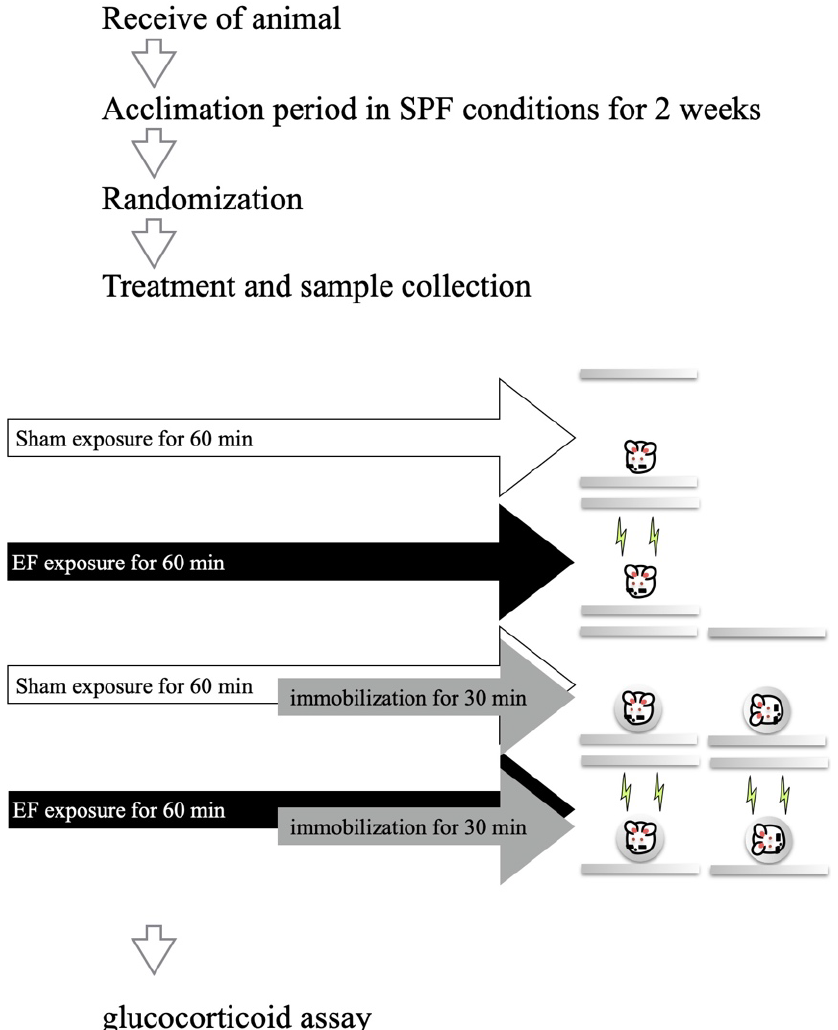
Figure 2. Experimental design to test the effects of different mice postures when immobilized and/or exposed to EF. The 96 mice were divided into six groups ( n = 16 per group): control (stress( − )/EF( − )), EF-alone (stress( − )/EF(+), two immobilization-alone (stress(+)/EF( − )), and two cotreatment (stress(+)/EF(+)) groups. The mice were placed in abdominal or lateral recumbent position. In the abdominal and lateral recumbent positions, the EF vector was perpendicular to the frontal and sagittal planes of the mouse, respectively.